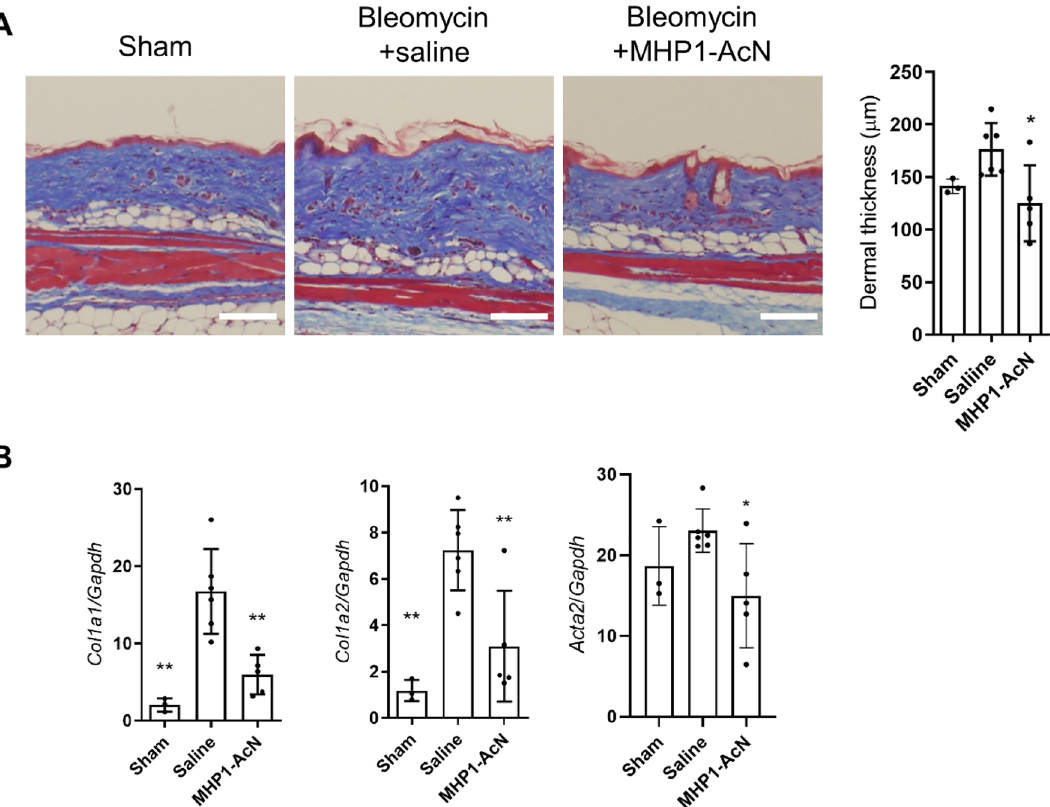
Figure 6. MHP1-AcN prevented the progression of bleomycin-induced skin fibrosis. ( A ) Typical images of Masson’s trichrome staining (left panel) and quantification of dermal thickness (right panel) on day 28. Bar = 100 µm. ( B ) Expression of Col1a1 , Col1a2 , and Acta2 on day 28. Fibrosis was inhibited in both histology and mRNA expression in MHP1-AcN-treated mice. *p < 0.05, p < 0.01 vs saline-treated mice. n = 3 in sham- operated group, n = 6 in saline-treated group, n = 5 in MHP1-AcN-treated